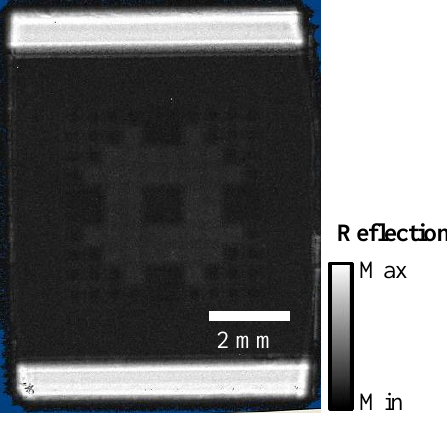
Figure 11. SAM image of bonded wafers with photonic-crystals pattern.